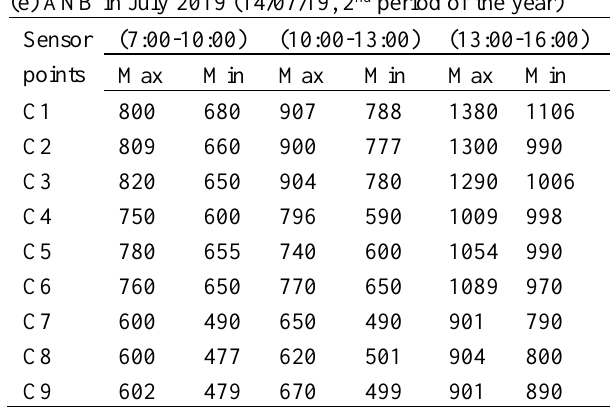
Average illuminance distribution in